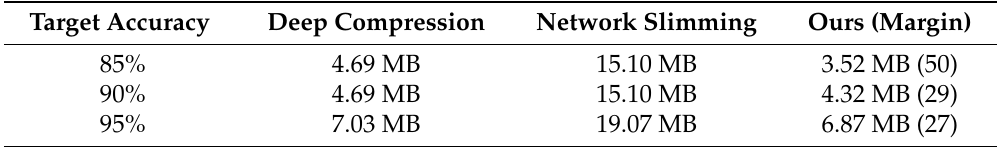
Table 6. The sizes of the minimized models in the corresponding accuracies derived from the proposed method and the individual cases of network slimming and deep compression for